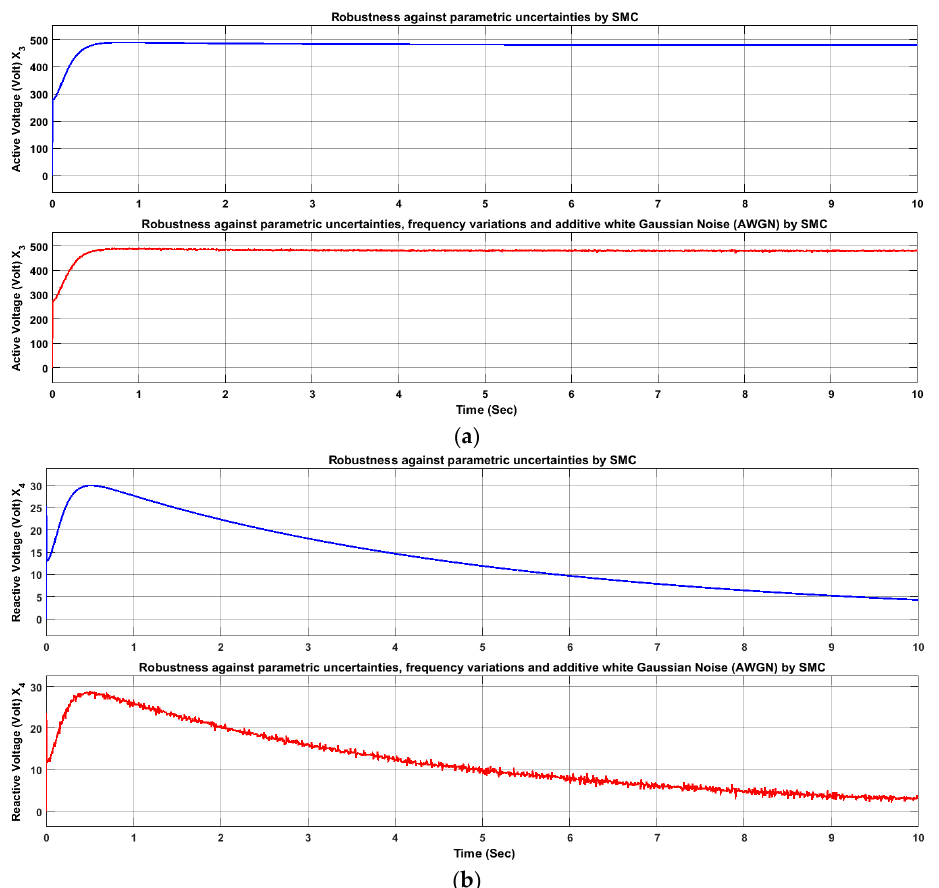
Figure 16. ( a ) d-axis bus voltage comparison; ( b ) q-axis bus voltage comparison, between robustness analysis against parametric variation and robustness analysis against parametric uncertainties, frequency variation and additive Gaussian noise using SMC control technique based on boundary conditions.